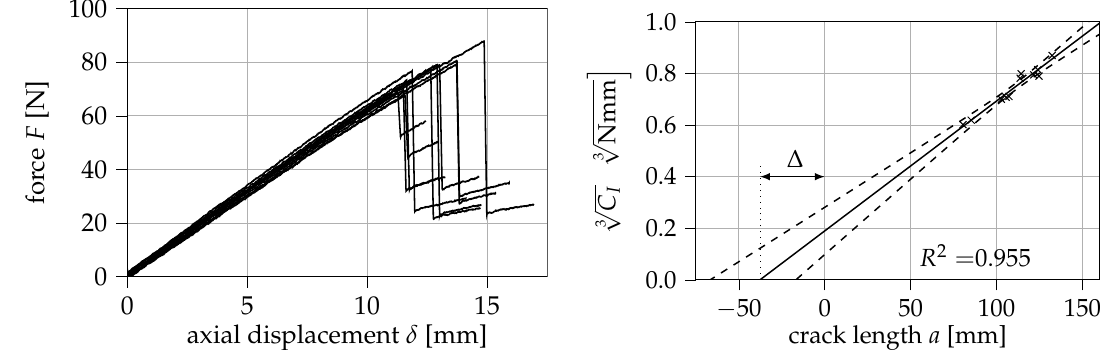
Figure 7. Measured force-displacement curves in mode I ( left ) and cube root of compliance over crack length with 5% confidence bands ( right ). Eleven specimens were